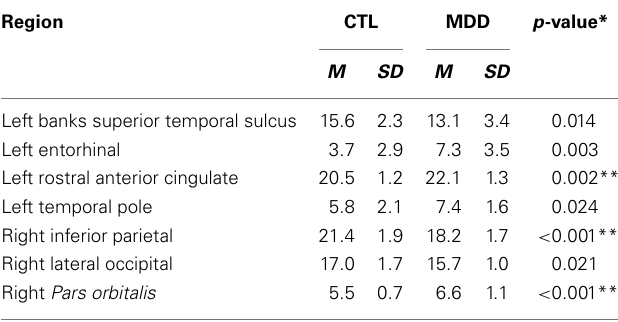
Table 6 | Regional degree centrality by group